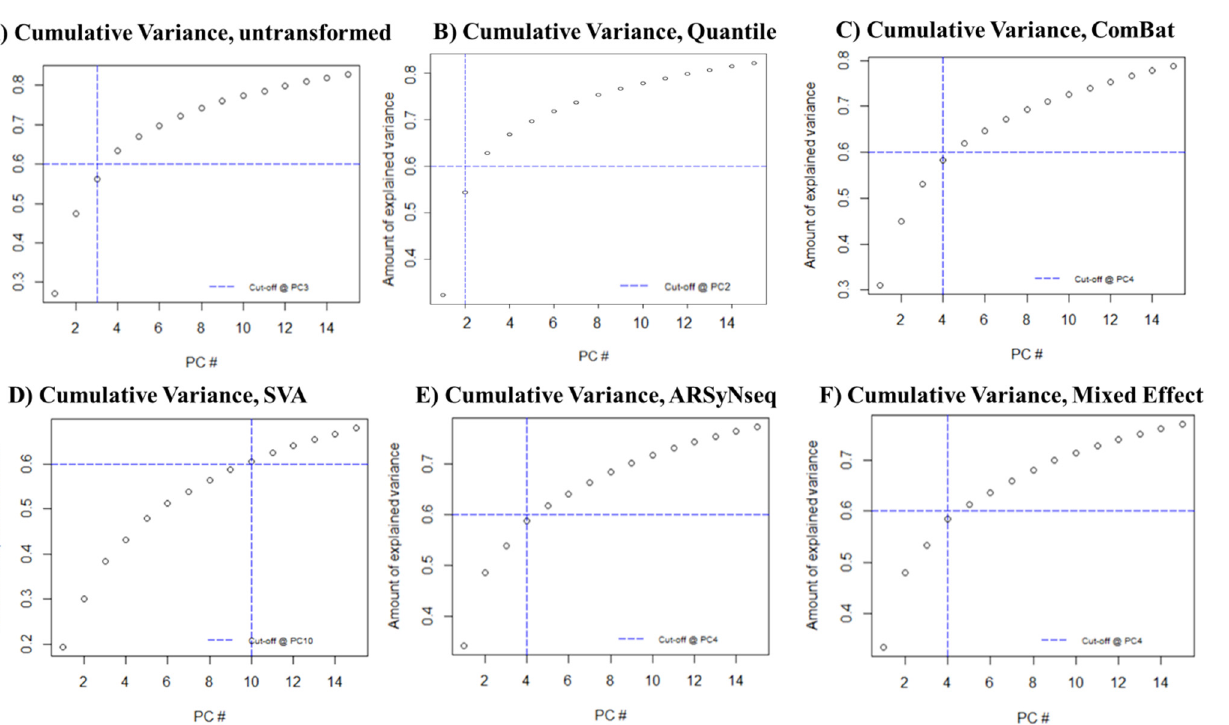
Figure 2. Cumulative variance plots for the 5 datasets, based on a threshold of 0.6. ( A ) Untransformed scaled; ( B ) quantile: ( C ) ComBat; ( D ) SVA; ( E ) ARSyNseq; and ( F ) mixed effect model.